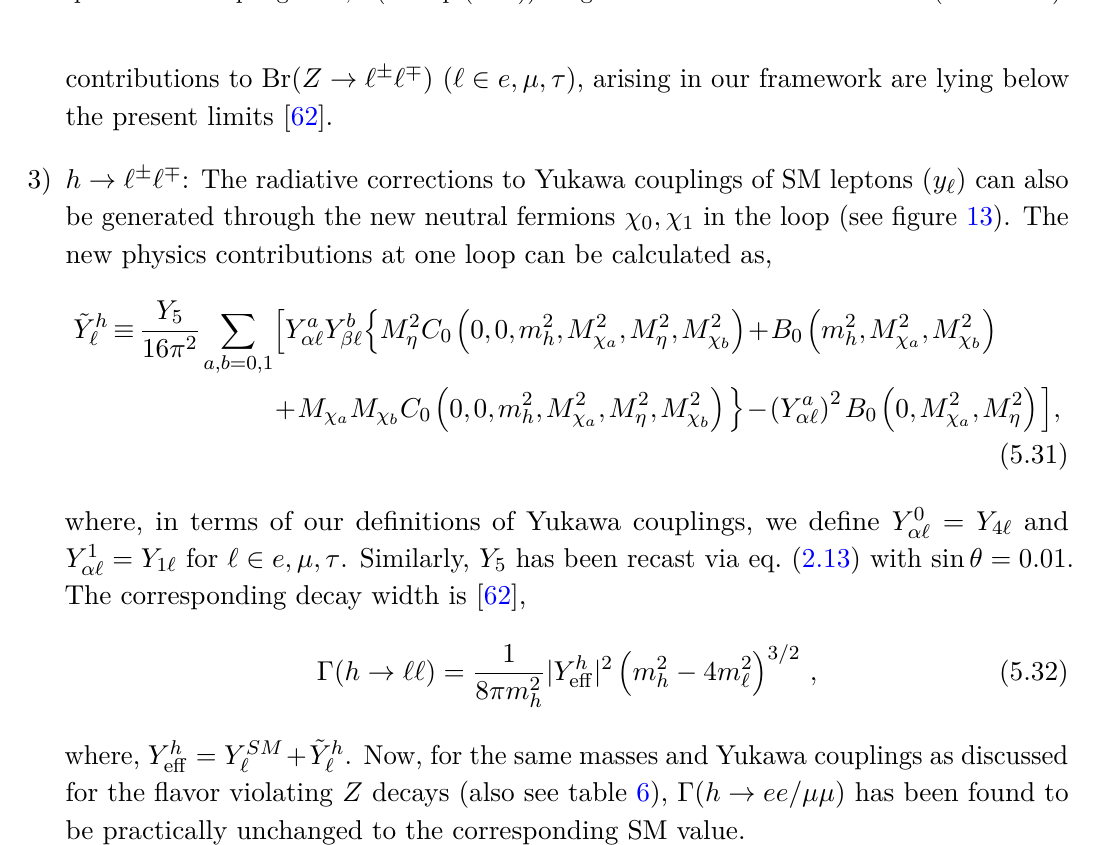
Figure 13 . Representative diagram for h → ‘‘ processes. Here a, b = 0 , 1 and α, β stand for the flavor specific new couplings = 1 , 4 (see eq. (2.14)). Leg corrections are also considered (not